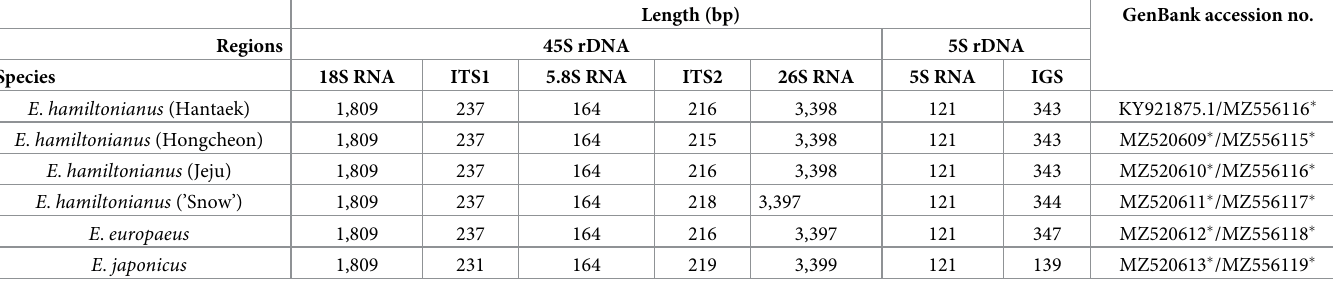
Table 2. Information about the nuclear ribosomal DNA (nrDNA) assembly of the six Euonymus